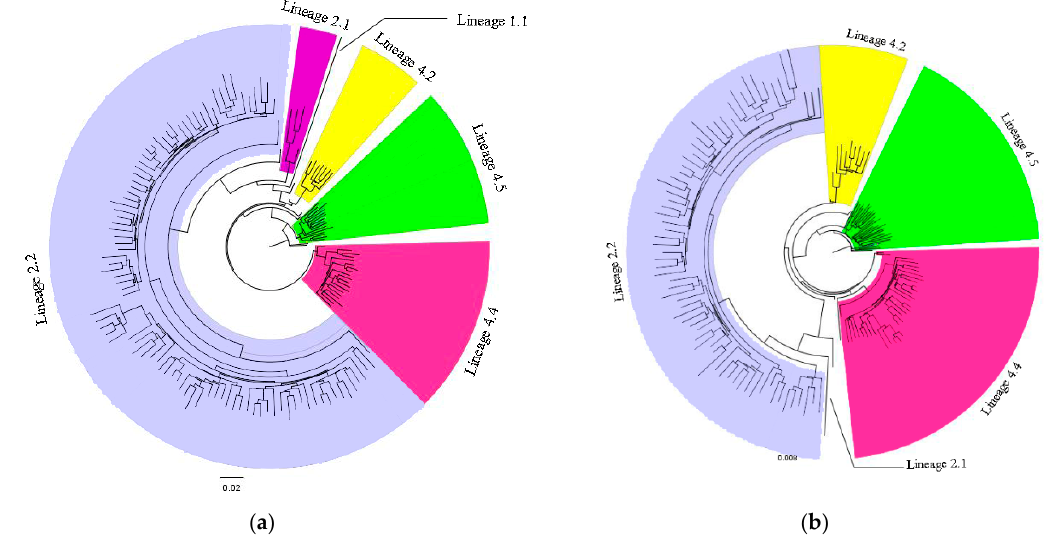
Figure 3. Phylogenetic tree of Mtb strains found in hot and cold spot counties. ( a ) Hot spot counties; ( b ) Cold spot counties. ( b ) Cold spot